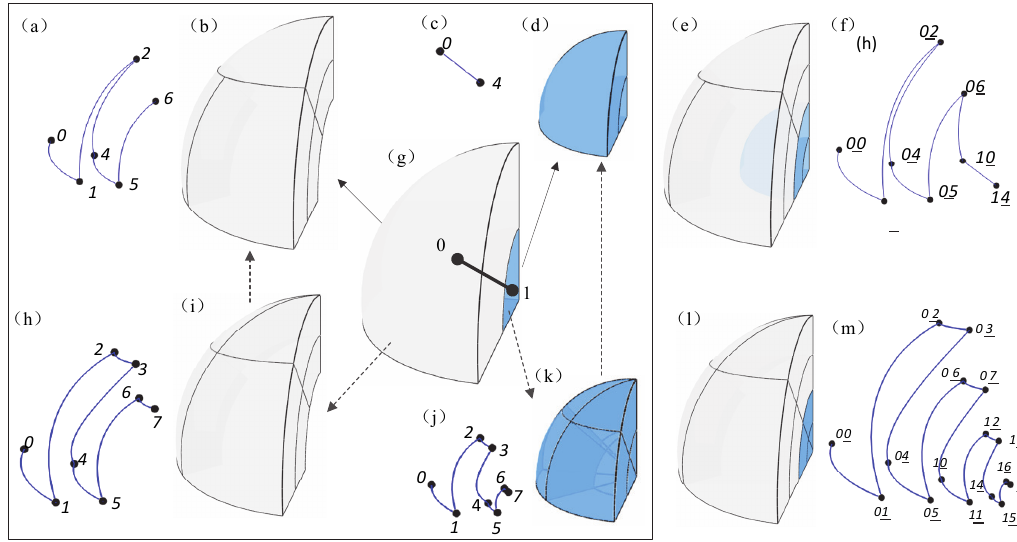
Figure 5 Methods of SDOG-R encoding. (a) The encoding scheme of the grids shown in (b); (b) the result of degenerated-octree partition on the first part of (g), which can also be achieved by local aggregation in (i); (c) the coding scheme of the grids shown in (d); (d) the result of degenerated-octree partition on the second part of (g), which can be achieved by a local aggregation in (k); (e) SDOG-R(1,1); (f) the coding scheme of SDOG-R(1,1); (g) bisection along the radial dimension on an octant or an SG; (h) the coding scheme of the grids shown in (i); (b) the result of octree partition on the first part of (g); (j) the coding scheme of the grids shown in (k); (k) the result of octree partition on the second part of (g); (l) the result of octree partition on (g); (m) the coding scheme of the grids shown in (l).